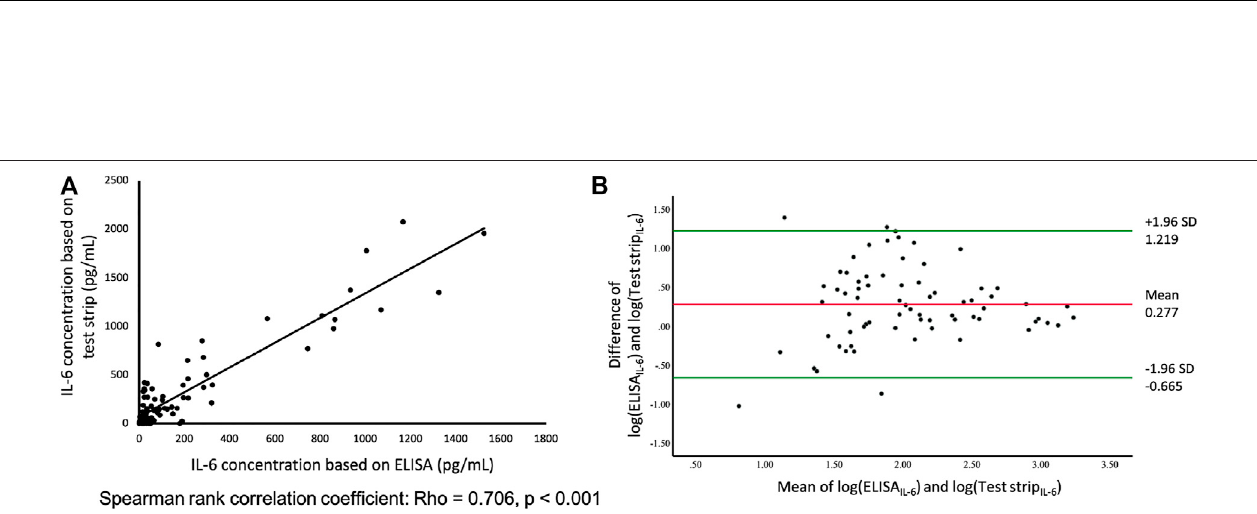
Frontiers in Bioengineering and Biotechnology |